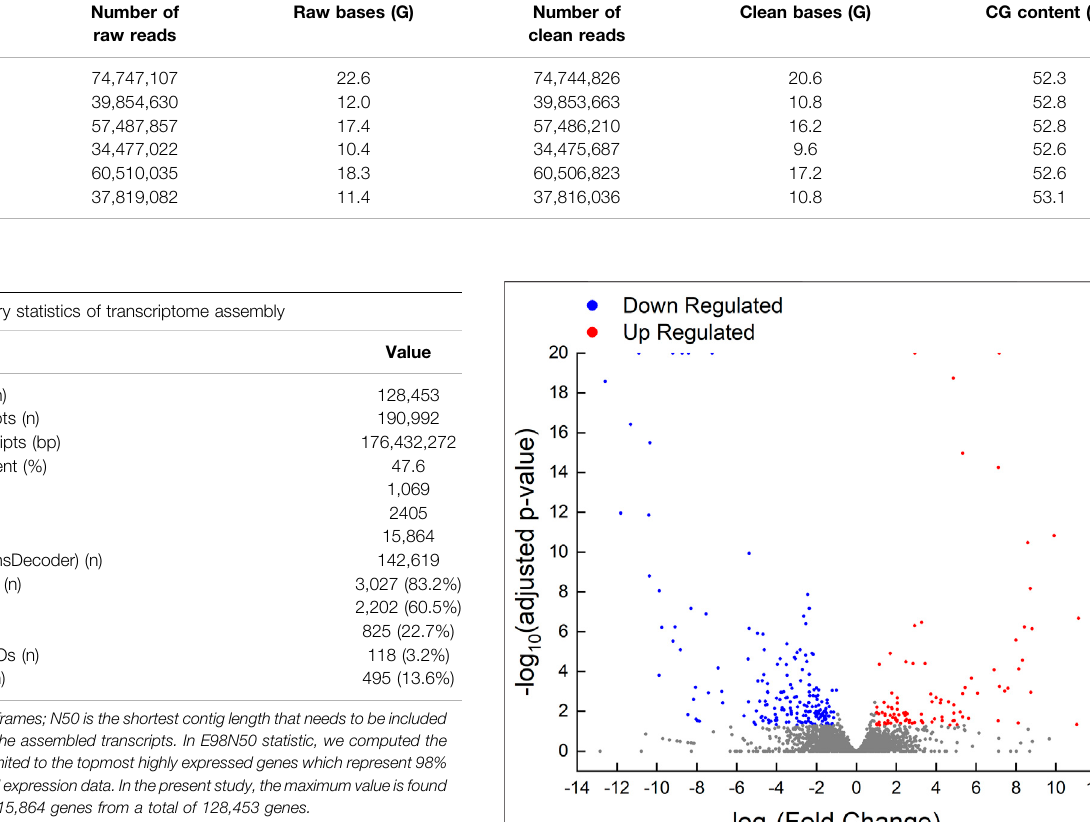
TABLE 1 | Summary of transcriptome data of black porgy (ovarian tissue from three control fi sh with ovotestis and three testis-removal fi sh) Sample